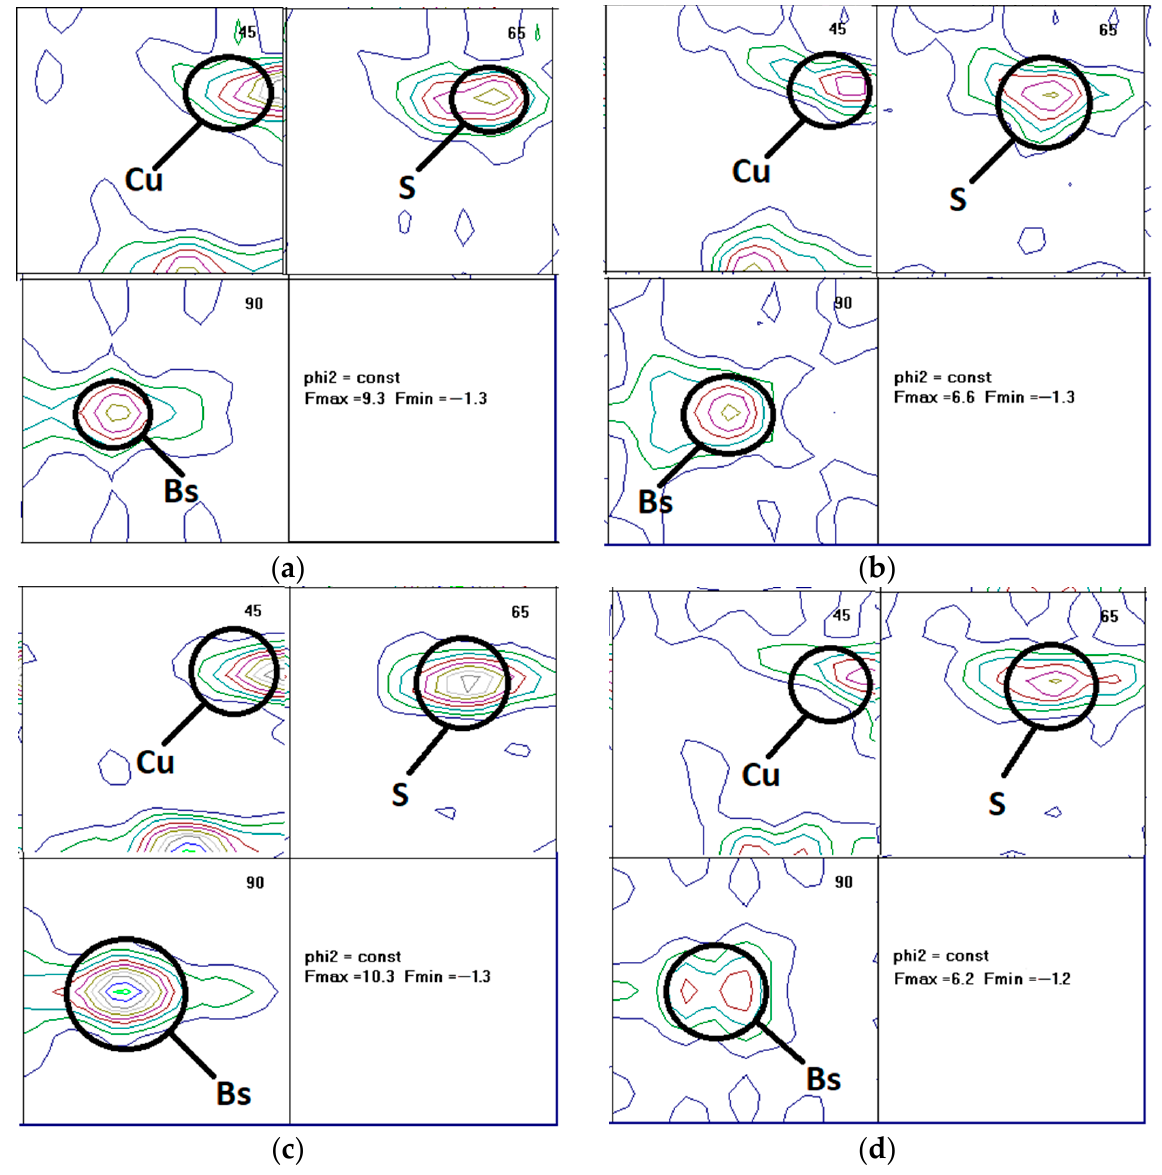
Figure 7. ODF , Al + 4% Mg (composition, see Table 3) compressed under plain strain to 80% engineering strain, material initially as cast, strain rate ( a , b ) 1 s − 1 ; ( c , d ) 10 s − 1 ; temperatures ( a , c ) 300 ◦ C; ( b , d ) 450 ◦ C.